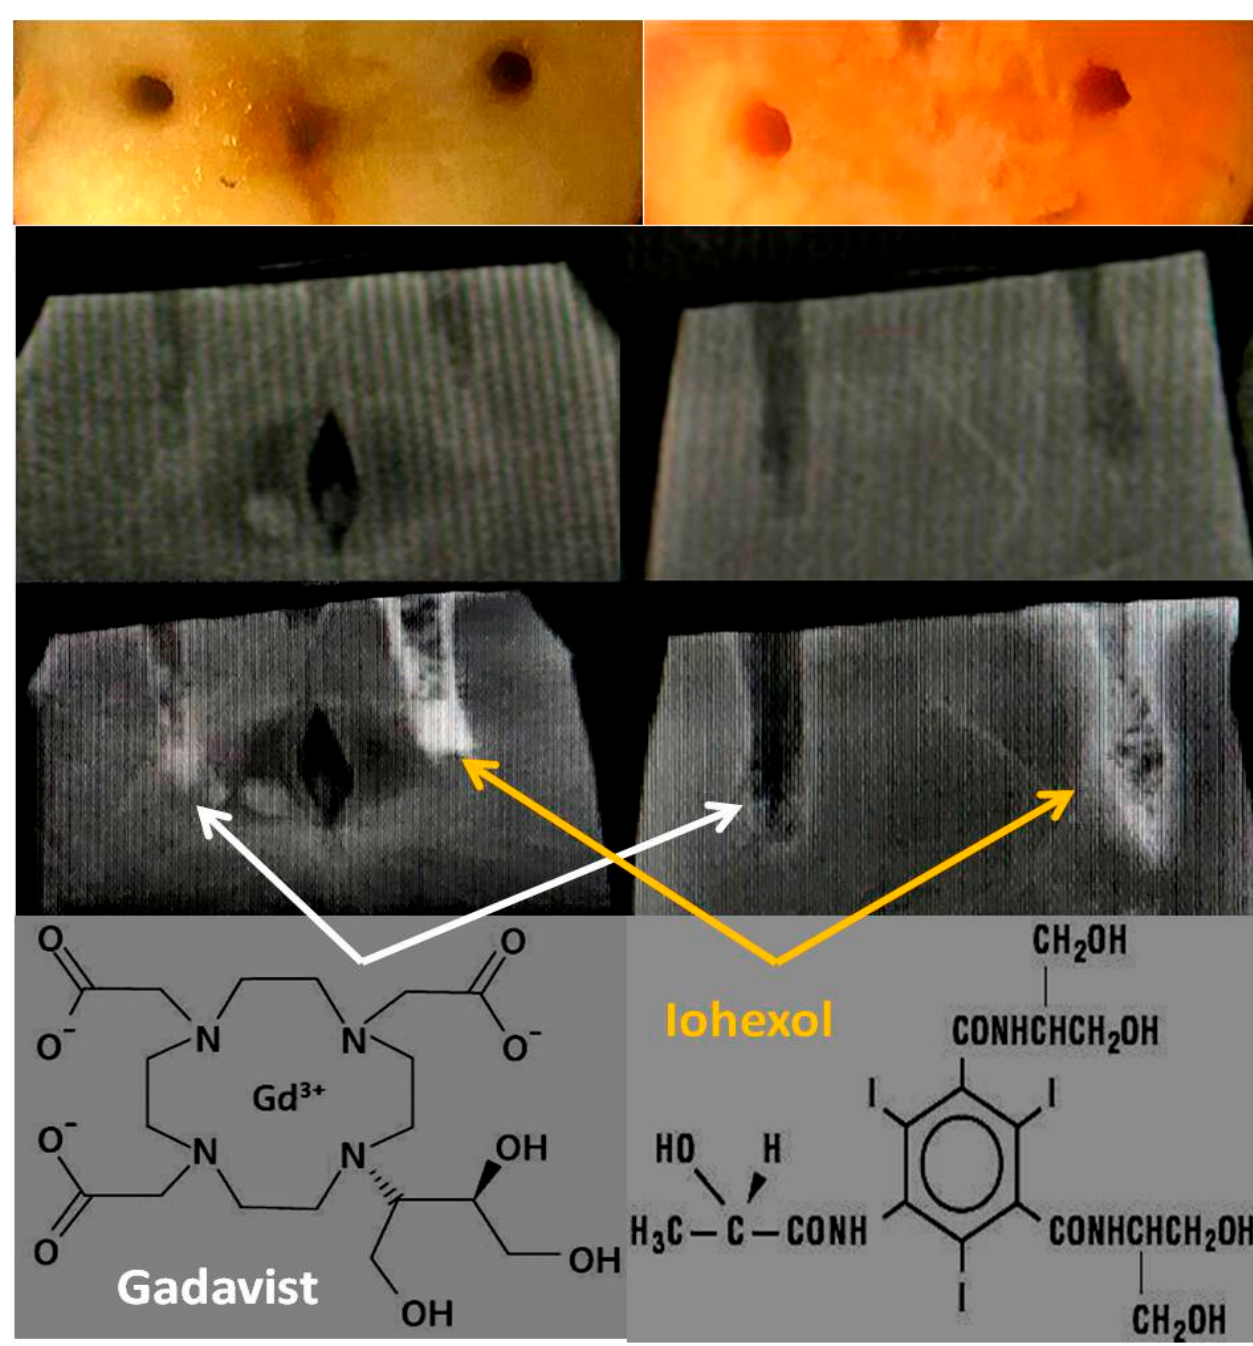
Figure 2. X-ray images of the mineral-rich model fruits and vegetables. 1st row: Cut samples: apple (left) and sweet potato (right) and manually carved holes (2 × 2 × 10 mm 3 or 0.04 mL for apple and approx 3.3 × 3.3 × 20 mm 3 or 0.2 mL for sweet potato). 2nd row: Pre-contrast X-ray images at 44 keV/15 mAs by a clinical scanner. 3rd row: Post-contrast X-ray images showing Gadavist is perfused in the left wells (white arrows) and Iohexol in the right wells (yellow arrows) for both fruits. 4th row: Molecular structures of both of the contrast media.